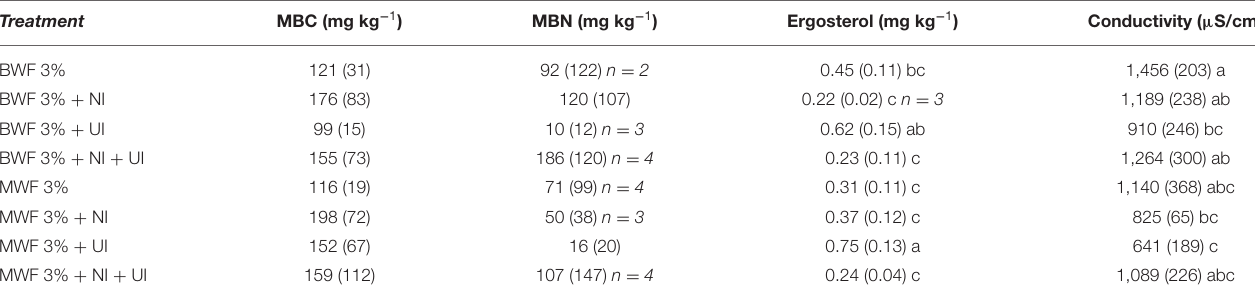
TABLE 6 | Microbial biomass C (MBC), N (MBN), ergosterol content and conductivity, at the end of the experiment (mean ± standard deviation for n = 5 except where indicated).